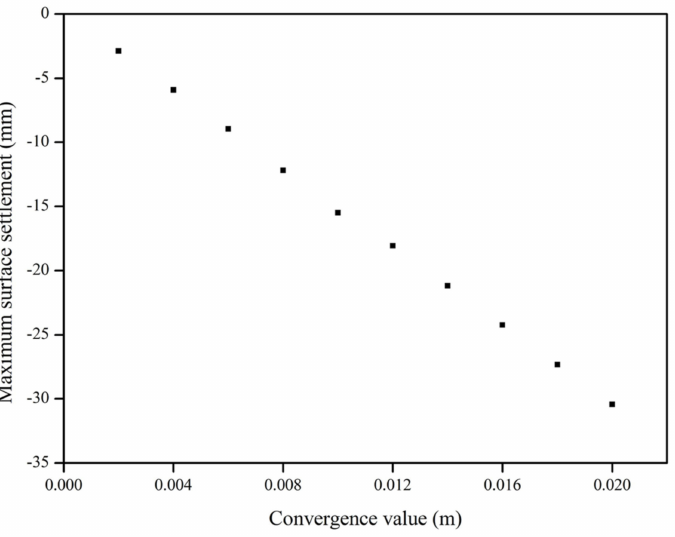
Figure 18. Variation of maximum